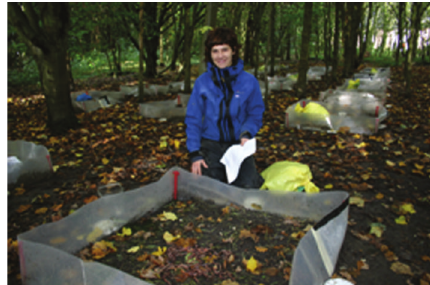
Figure 1: Earthworm enclosures (1m 2 ) used for manipulating density of Lumbricus terrestris in managed woodland (earthworms added to enclosure in foreground).